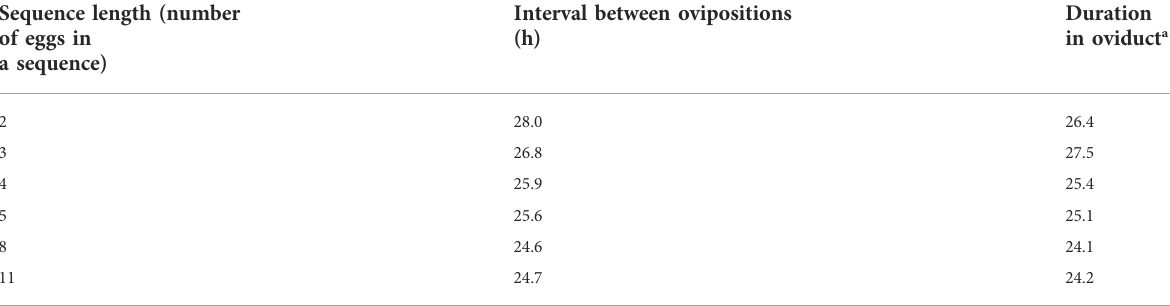
Interval between ovipositions (h)